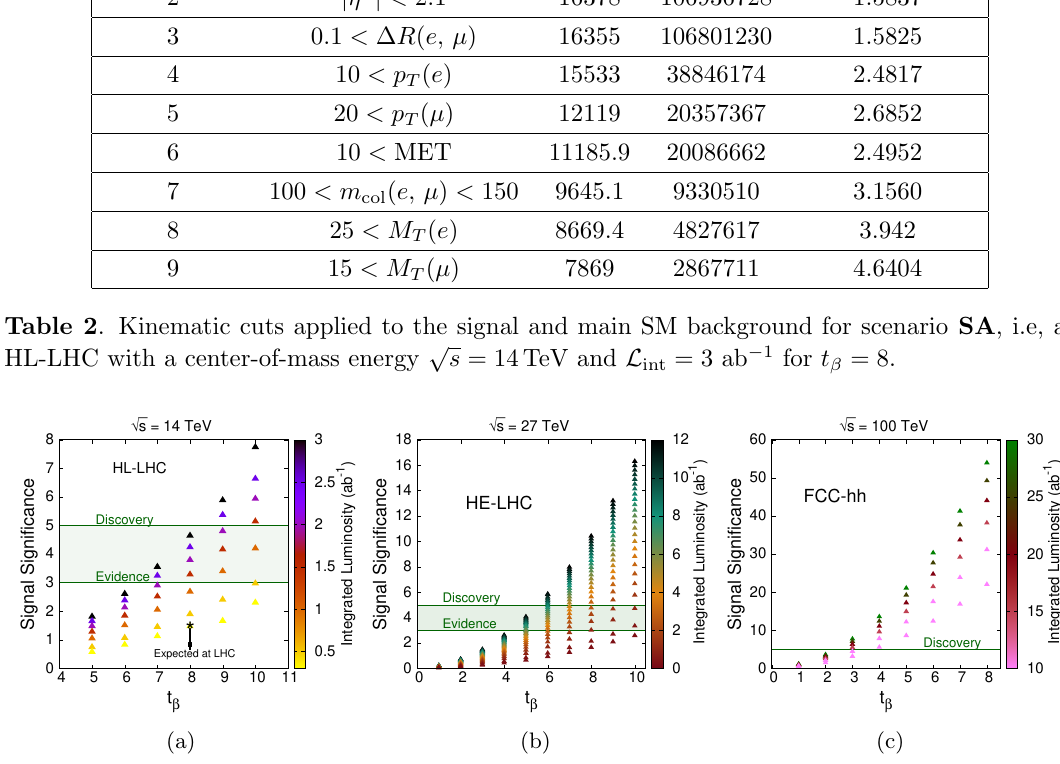
(cid:12) and integrated luminosities associated to each